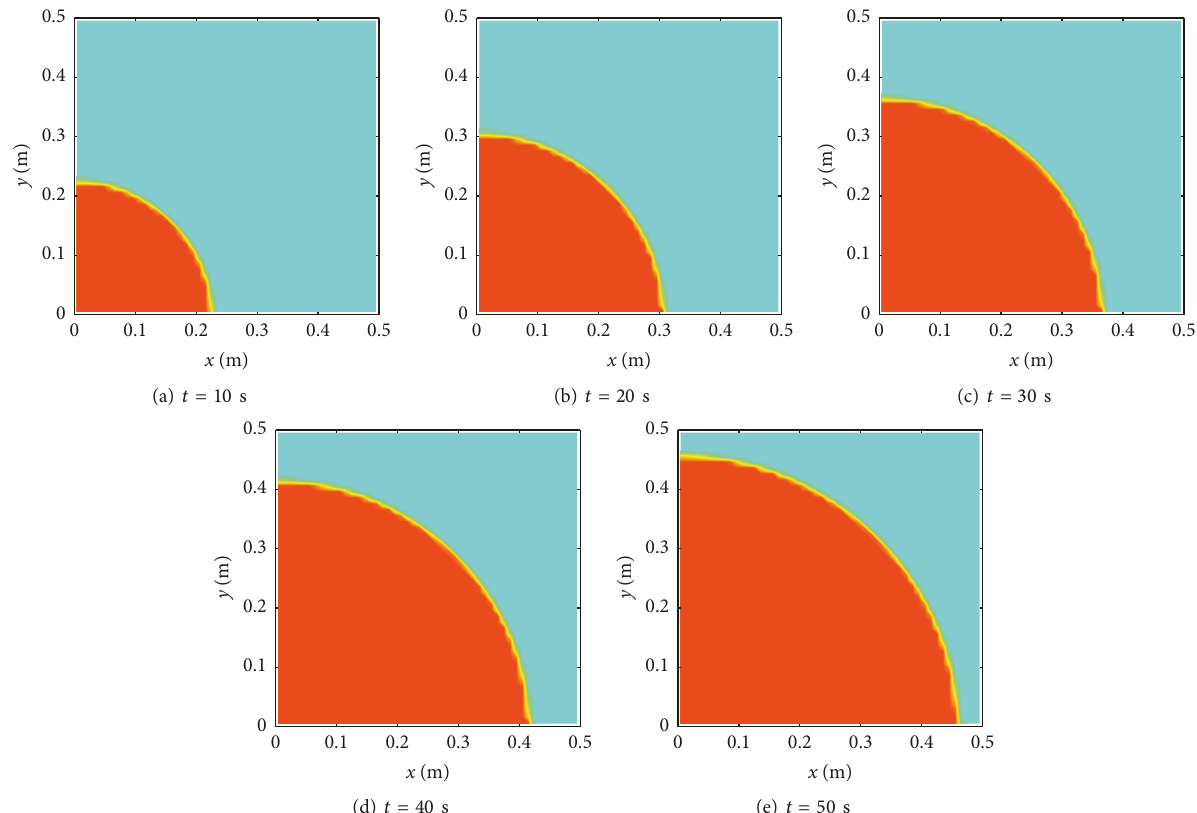
Figure 11: Change of grout diffusion front positions with time.